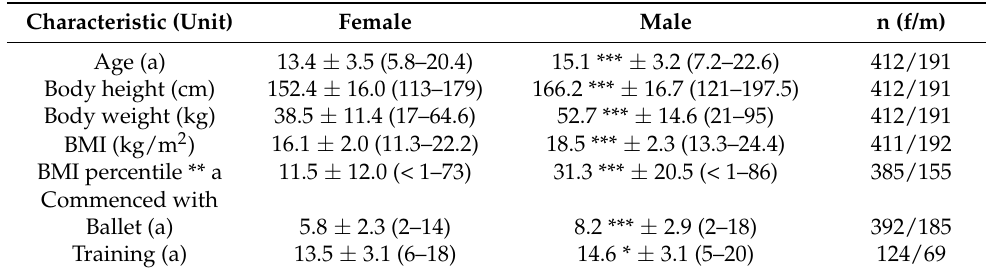
Table 2. Sociodemographic characteristics, Mean ± SD (Range).